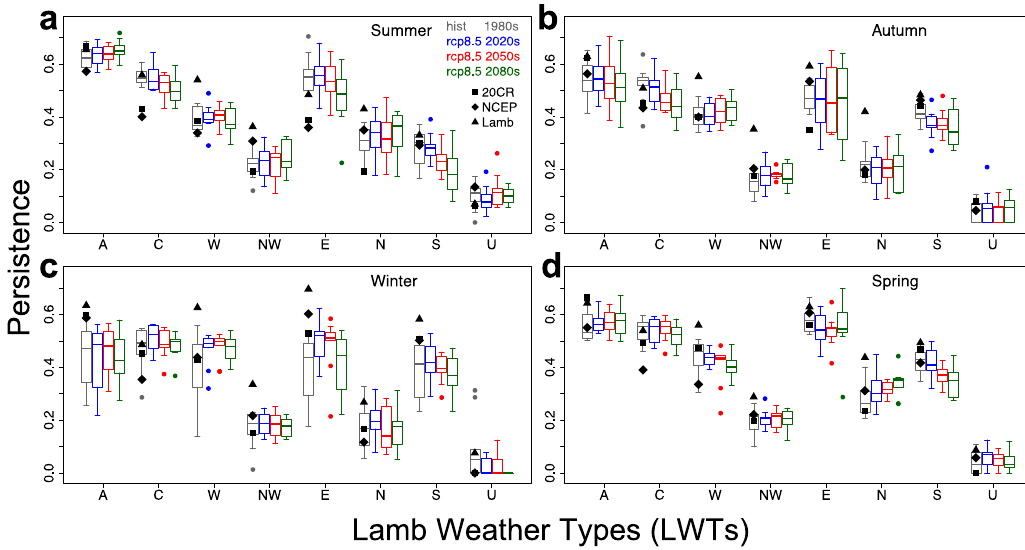
Figure 3. Persistence of the seven main Lamb Weather Types (LWTs) plus unclassified (U) type under Representative Concentration Pathway (RCP) 8.5. Persistence is calculated for ( a ) summer June-July- August (JJA), ( b ) autumn September-October-November (SON), ( c ) winter December-January- February (DJF) and ( d ) spring March-April-May (MAM), for the historical 1980s (1971–2000) and under RCP8.5 by the 2020s (2011–2040), 2050s (2041–2070) and 2080s (2071–2100). Boxplots show distributions of persistence in each LWT, for the 10-member Atmosphere-Ocean General Circulation Models (AOGCM) ensemble, compared with the 20th Century (20CR), National Center for Environmental Prediction (NCEP) reanalyses and the Lamb’s subjective catalogue. Segments show the minimum, 1st quartile, median, 3rd quartile and maximum. Outliers are shown by dots. W-type persistence agrees with the reanalyses but is always less than in Lamb’s catalogue.